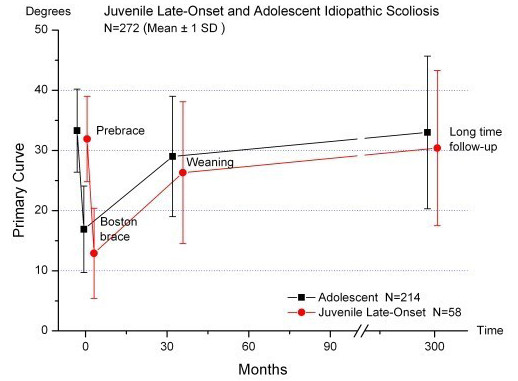
Longitudinal development of the major curve in late-onset juvenile and adolescent idiopathic scoliosis classified according to the status at follow-up. Mean Cobb angle ± 1 SD prebrace, at brace weaning, and at long-term follow-up in patients with final major curve < 45° (N = 215), final major curve ≥ 45° (N = 32), and operated patients (N = 25).